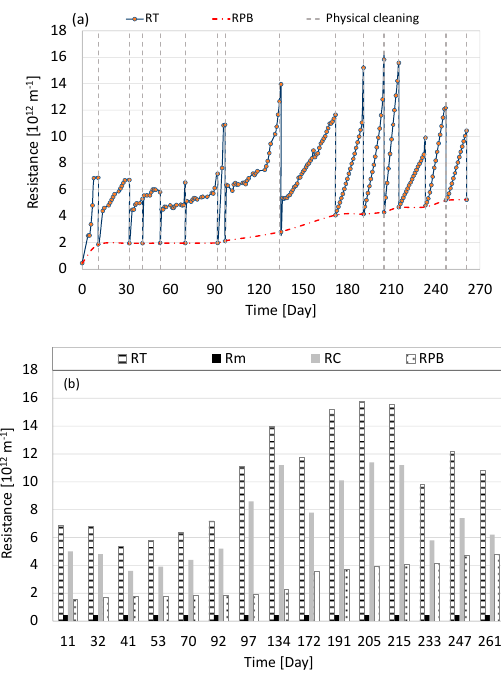
Figure 9. Trend of the total resistance ( a ); results related to the resistance-in-series (RIS) model application ( b ).